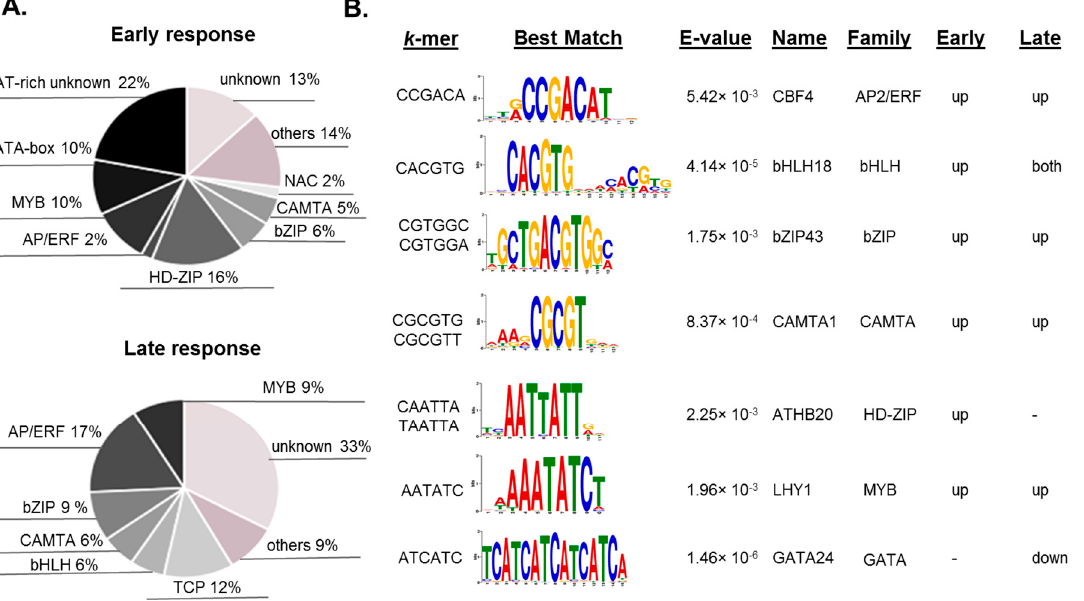
Figure 2. Cis -regulatory elements predicted with metaRE as systematically enriched in upstream regulatory regions of cold-induced genes in Arabidopsis. ( A ) Annotation of the hexamers to the known binding sites of Arabidopsis thaliana with the help of the TOMTOM tool [24]. Only significant best matches (E-value < 0.05, one per hexamer) were calculated to build the round diagram. ( B ) Annotation details for particular hexamers associated with early, late, or both early and late responses. The best significant matches of the hexamers with the known binding sites associated with downregulation in response to cold stress.